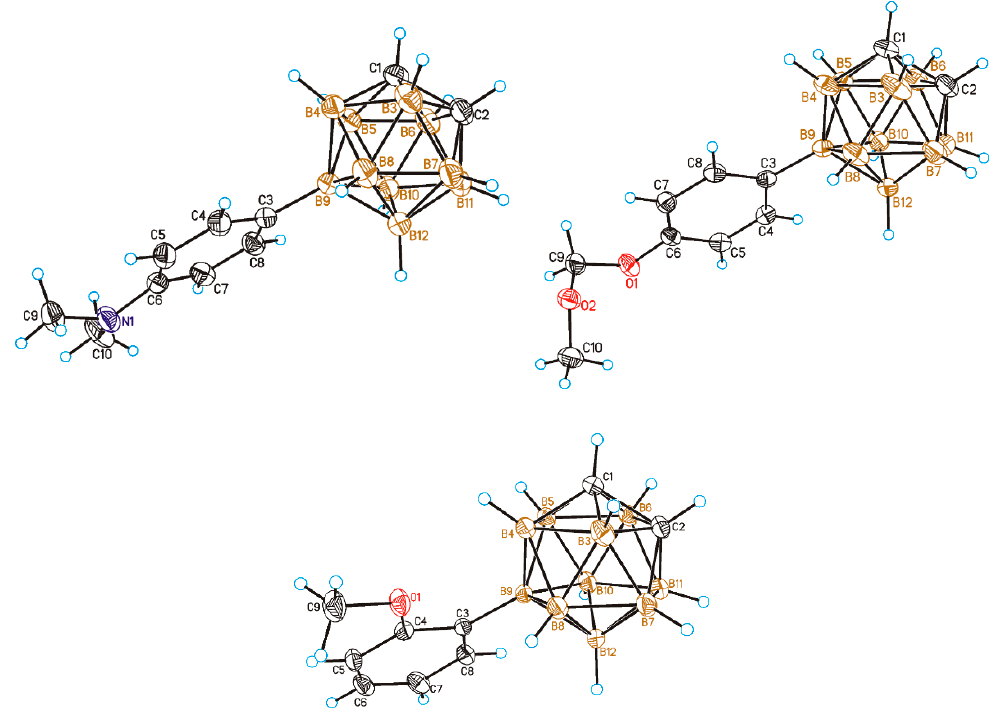
Figure 2. General views of 9-( p -Me 2 NC 6 H 4 )-1,2-C 2 B 10 H 11 ( 3 , topleft), 9-( p -MeOCH 2 OC 6 H 4 )-1,2-C 2 B 10 H 11 ( 4 , top right), and 9-( o -MeOC 6 H 4 )-1,2-C 2 B 10 H 11 ( 5 , bottom) showing atomic numbering. Thermal ellipsoids are drawn at 50% probability level.